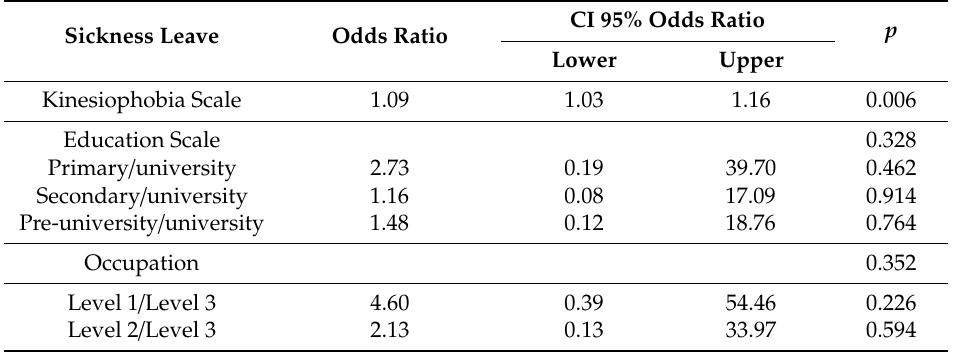
Table 3. Multiple logistic regression model: influence of kinesiophobia on sickness leave, controlled for educational and occupational level.